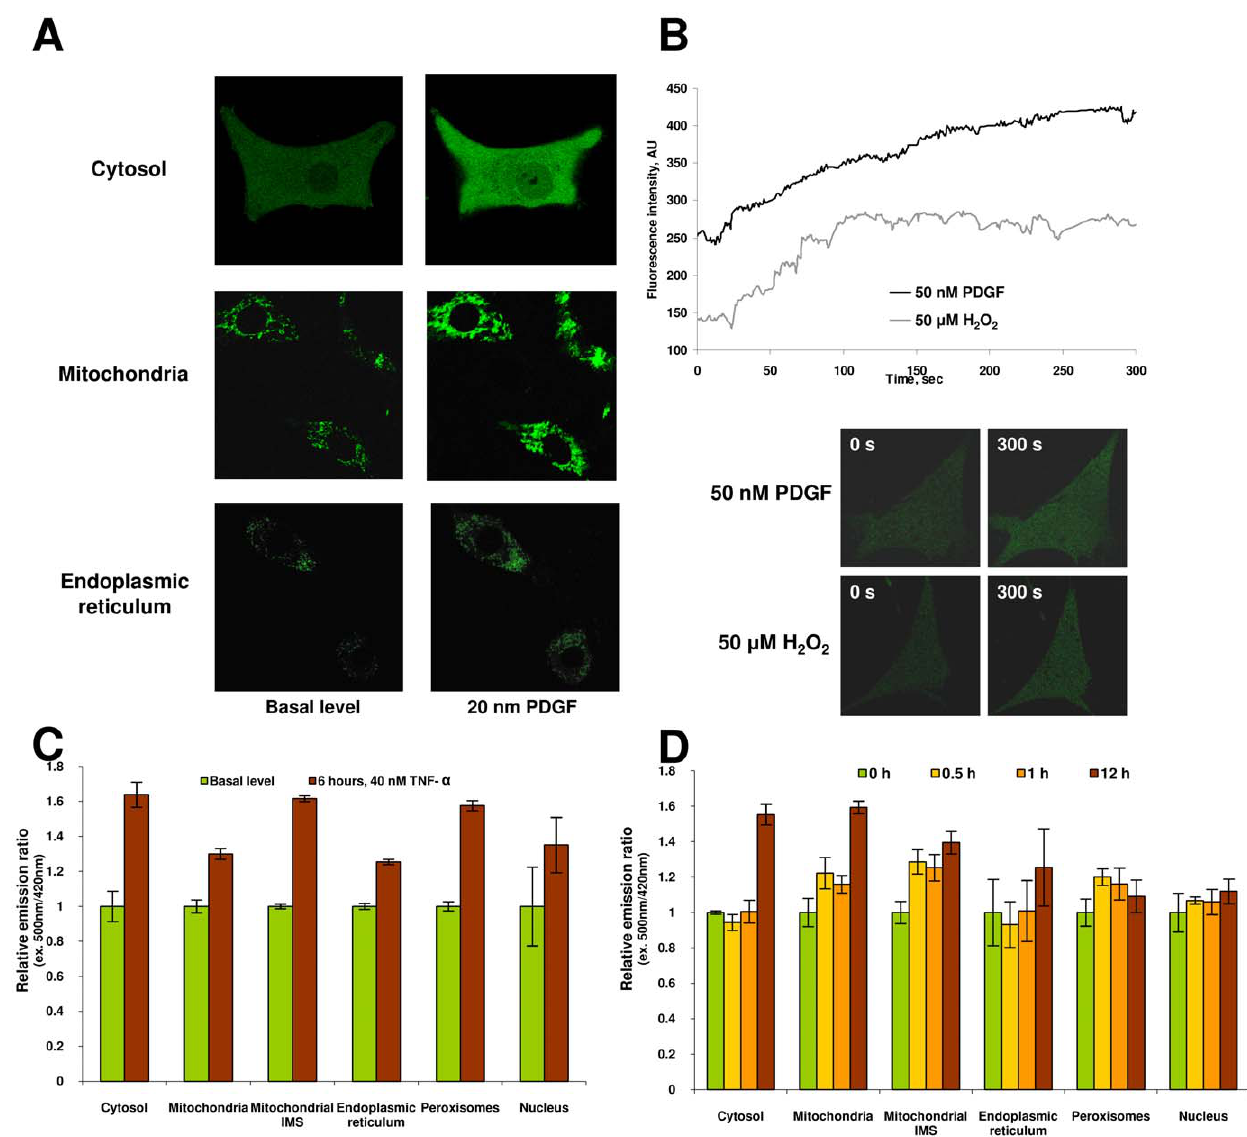
Figure 4. Changes in HyPer redox state following redox perturbations. (A) Response of HyPer expressed in various compartments of NIH 3T3 cells to PGDF. NIH 3T3 cells transiently expressing HyPer were stimulated with 20 nM PDGF for 10 min. Images obtained before and after treatment are shown. (B) Dynamics of intracellular fluorescent HyPer response in NIH 3T3 cells treated with 20 nM PDGF or 50 m M H 2 O 2 . Graphs represent mean fluorescence intensity of one representative cell in 5 min time-lapse. (C) Generation of H 2 O 2 during TNF- a signaling in various compartments of HEK 293 cells. HEK 293 cells were incubated with 40 ng/ml TNF- a for 6 h. Fluorescence was recorded at emission 530. (D) Inhibition of Complex I of mitochondrial ETC leads to H 2 O 2 generation in HEK 293 cells. Data represent mean of 3 measurements, 6 standard